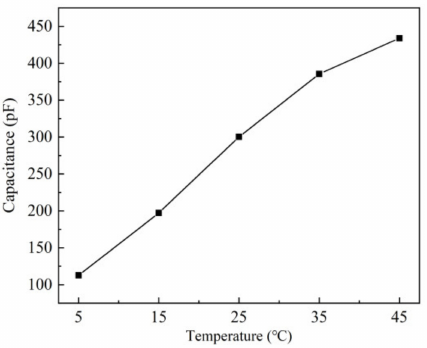
Figure 13. Effect of temperature on sensor capacitance under 60% RH.